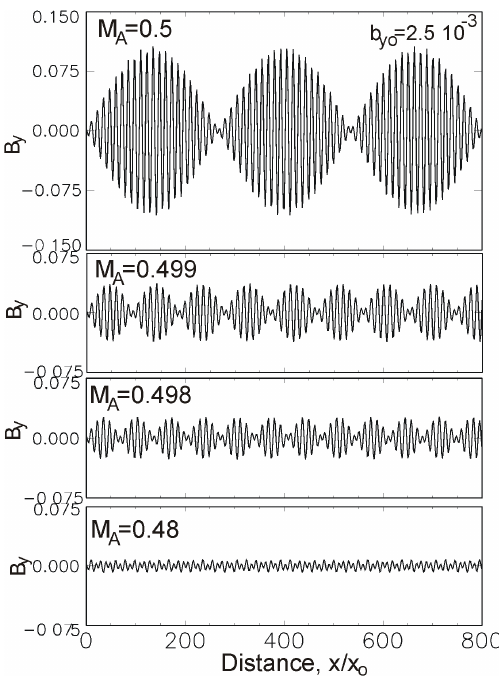
Fig. 13. Amplitude of periodic wave packets strongly decreases with deviation from M Ae = 1 /